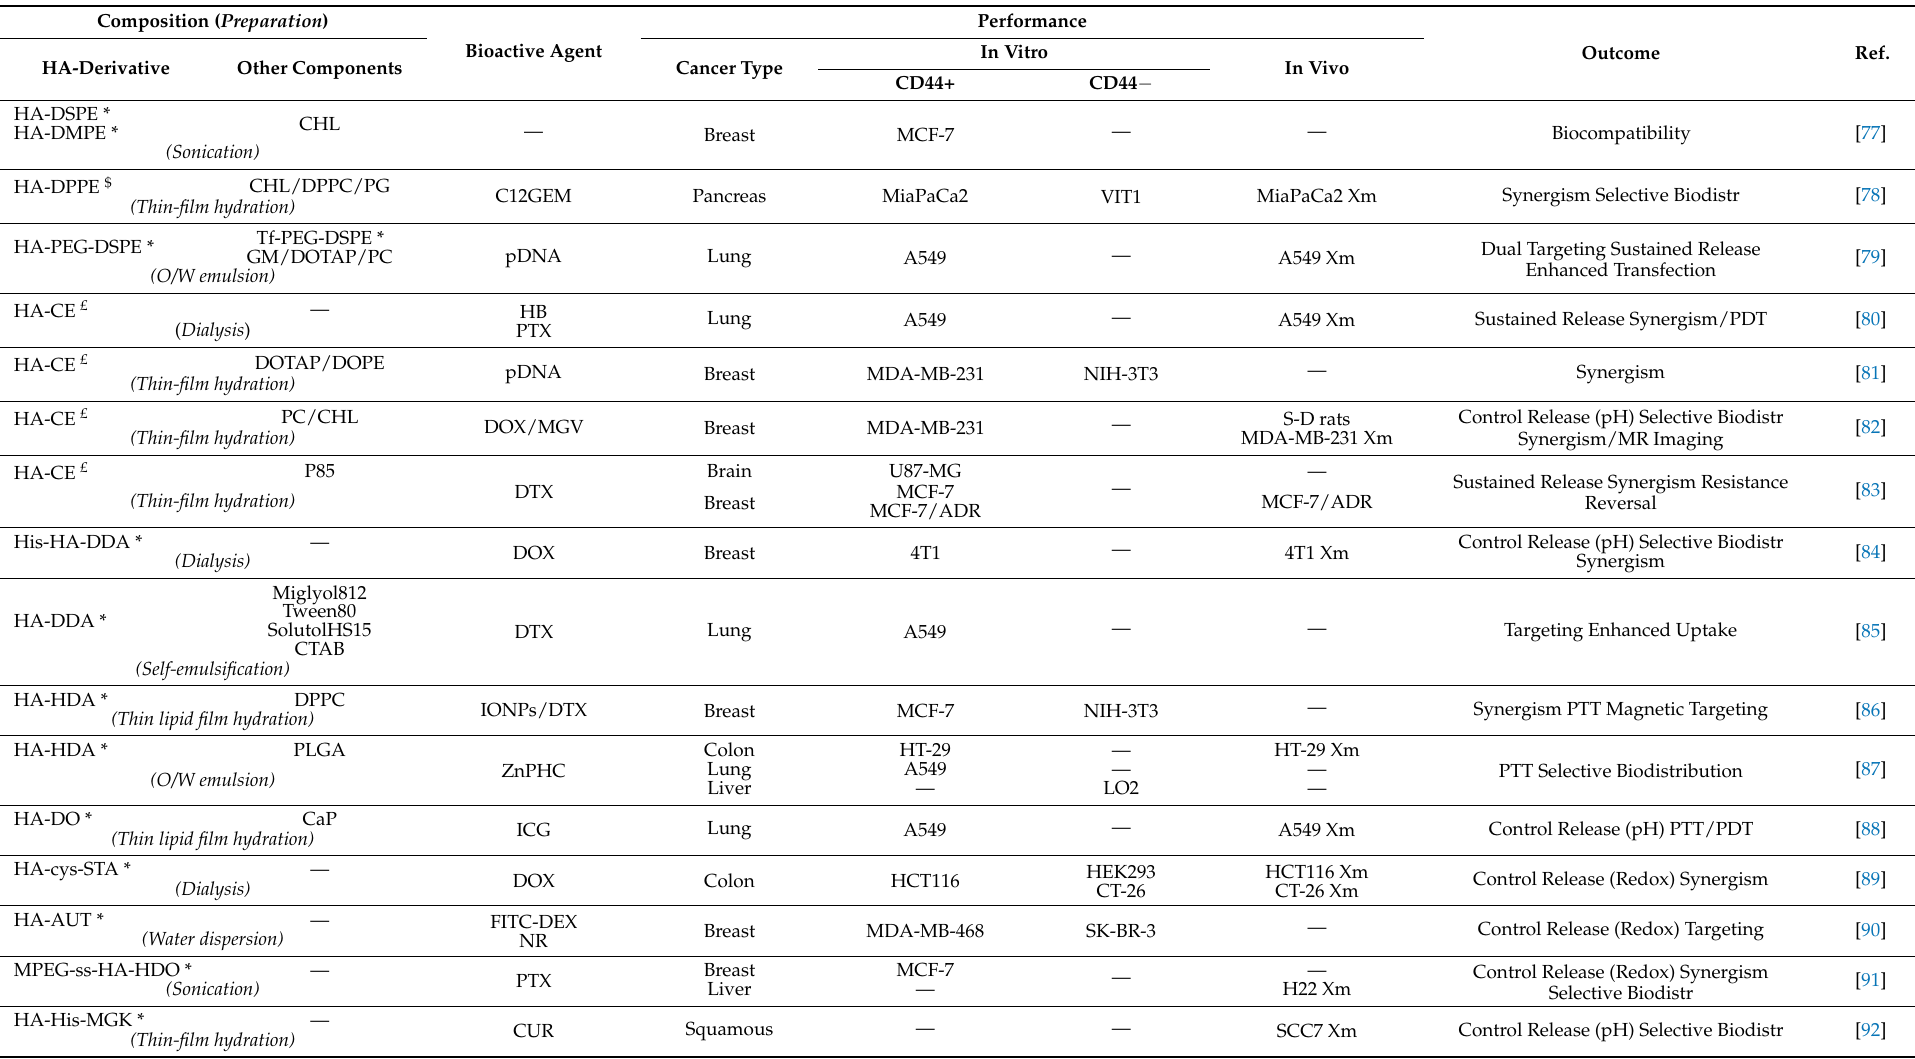
Table 3. HA-SANPs obtained by hydrophobic interactions of lipid-modified